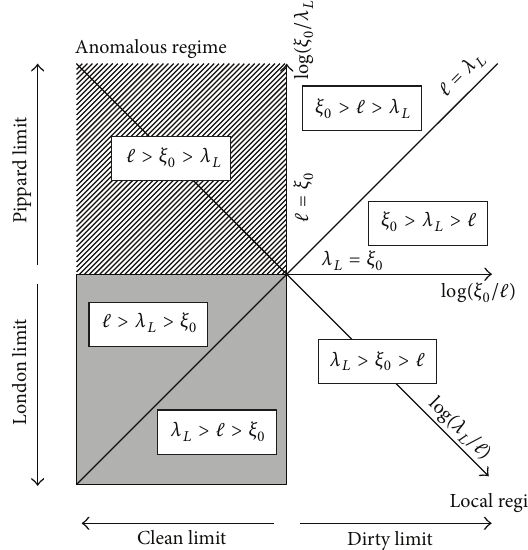
Figure 7: Schematic representation of the local, London, and Pippard limits in the parameter space given by the three length scales, the coherence length 𝜉 0 , the London penetration depth 𝜆 𝐿 , and the mean free path ℓ . In the local regime ℓ is smaller than the distance over which the electric field changes, ℓ < 𝜉(0) < 𝜆 . When ℓ/𝜉(0) → 0 the superconductor is in the so-called dirty limit. The opposite situation is in which ℓ/𝜉(0) → ∞ is the clean limit, in which nonlocal effects are important, and we have to consider Pippard’s treatment. This regime can be subdivided if we also consider the third parameter 𝜆 . The case 𝜉(0) > 𝜆 is the Pippard or anomalous regime, which is the regime of type I superconductors; 𝜉(0) < 𝜆 is the London regime, the regime of the type II superconductors